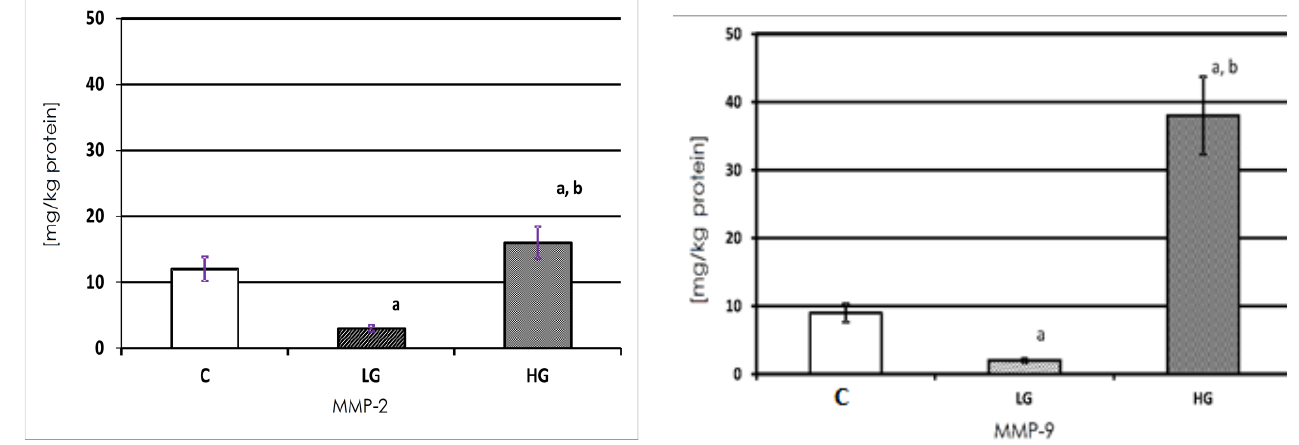
Figure 2. Content of MMP-2 and MMP-9 in control tissue and low-grade (LG) and high-grade (HG) urinary bladder cancer. a — p < 0.001 cancer vs. urinary bladder control; b — p < 0.001 high-grade vs. low-grade urinary bladder cancer.